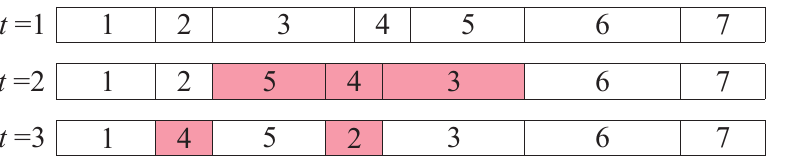
Figure 1. Example layout with three planning